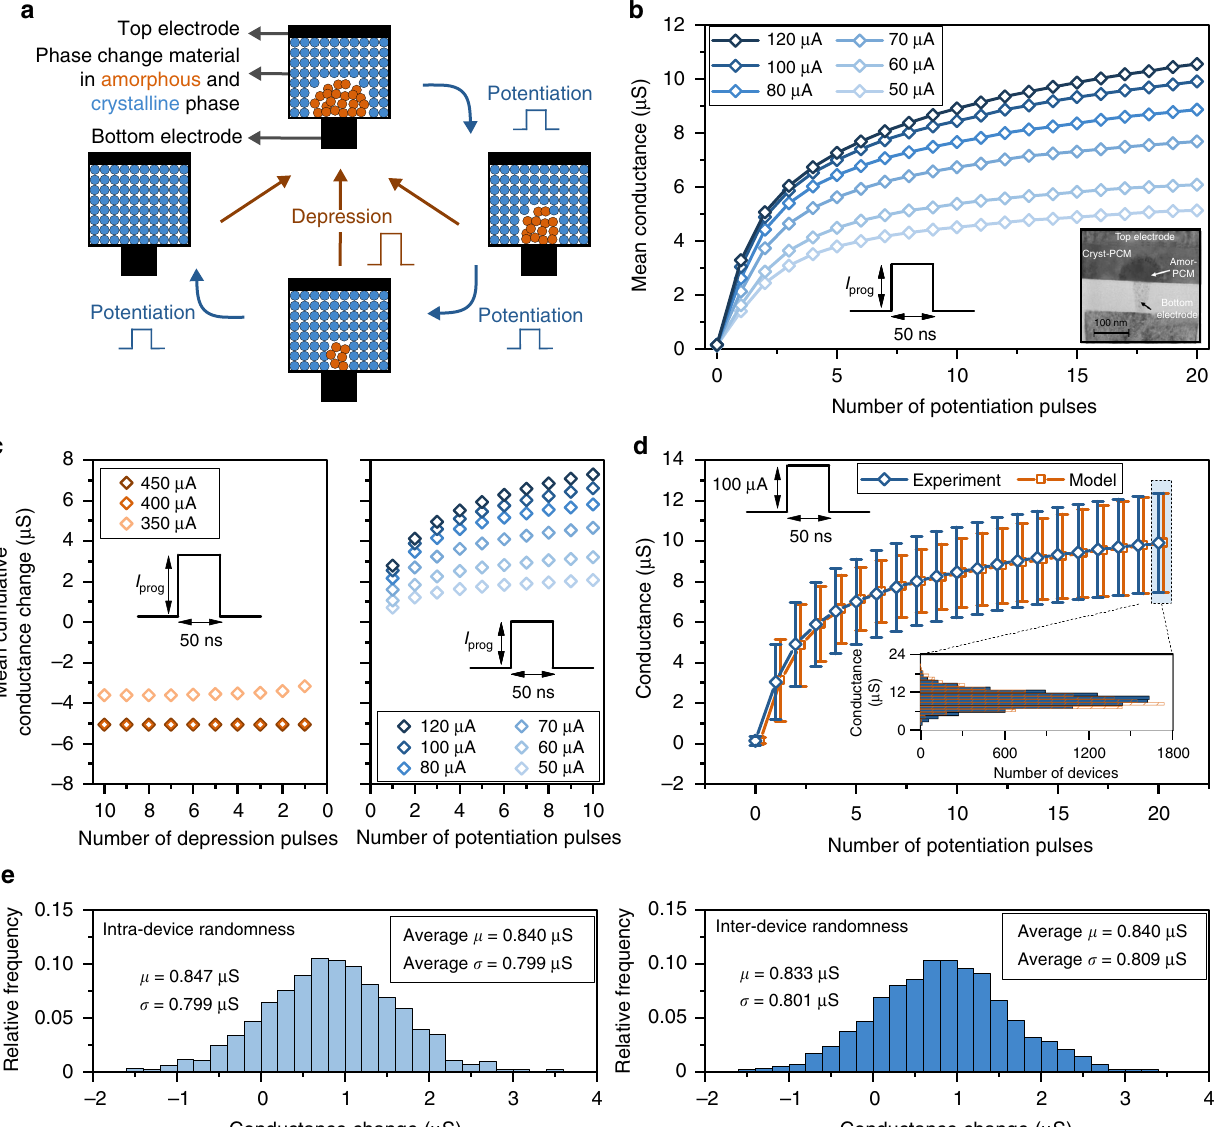
Fig. 2 Synapses based on phase change memory. a A PCM device consists of a phase-change material layer sandwiched between top and bottom electrodes. The crystalline region can gradually be increased by the application of potentiation pulses. A depression pulse creates an amorphous region that results in an abrupt drop in conductance, irrespective of the original state of the device. b Evolution of mean conductance as a function of the number of pulses for different programming current amplitudes ( I prog ). Each curve is obtained by averaging the conductance measurements from 9700 devices. The inset shows a transmission electron micrograph of a characteristic PCM device used in this study. c Mean cumulative conductance change observed upon the application of repeated potentiation and depression pulses. The initial conductance of the devices is ∼ 5 μ S. d The mean and the standard deviation (1 σ ) of the conductance values as a function of number of pulses for I prog = 100 μ A measured for 9700 devices and the corresponding model response for the same number of devices. The distribution of conductance after the 20th potentiation pulse and the corresponding distribution obtained with the model are shown in the inset. e The left panel shows a representative distribution of the conductance change induced by a single pulse applied at the same PCM device 1000 times. The pulse is applied as the 4th potentiation pulse to the device. The same measurement was repeated on 1000 different PCM devices, and the mean ( μ ) and standard deviation ( σ ) averaged over the 1000 devices are shown in the inset. The right panel shows a representative distribution of one conductance change induced by a single pulse on 1000 devices. The pulse is applied as the 4th potentiation pulse to the devices. The same measurement was repeated for 1000 conductance changes, and the mean and standard deviation averaged over the 1000 conductance changes are shown in the inset. It can be seen that the inter-device and the intra-device variability are comparable. The negative conductance changes are attributed to